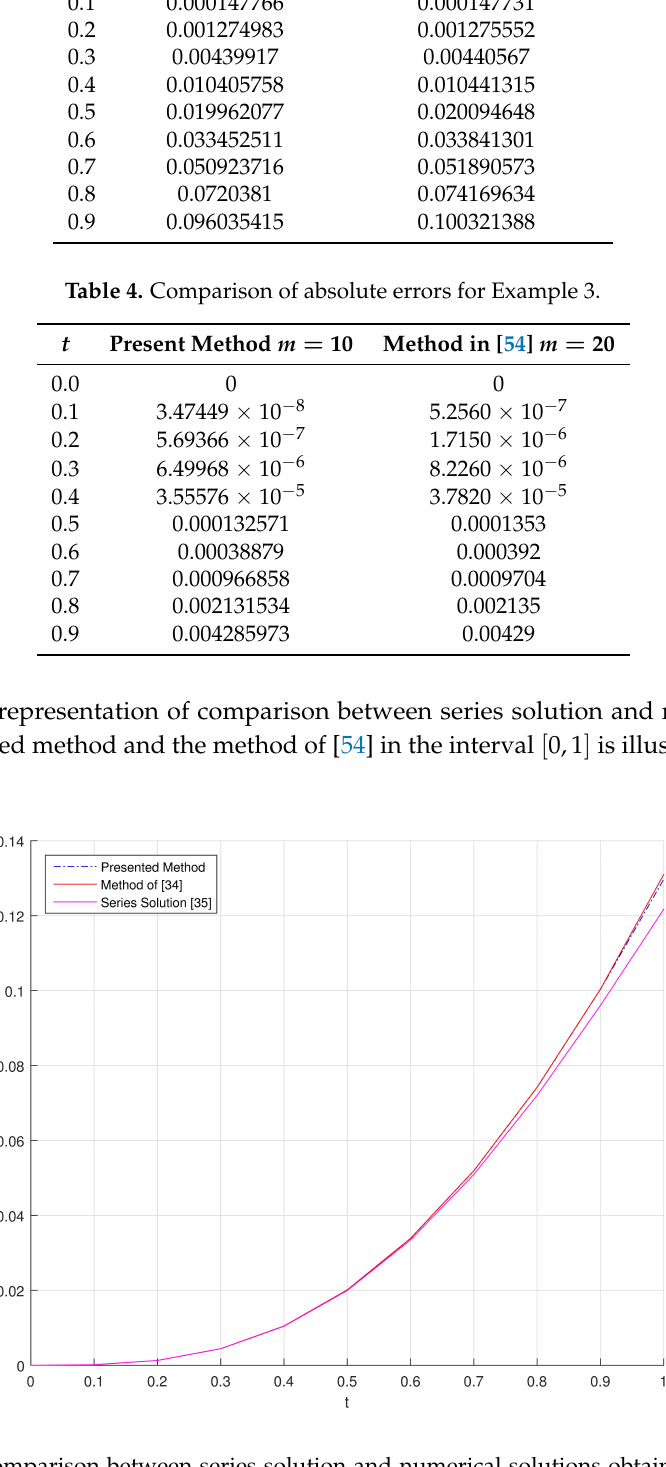
Figure 8. The comparison between series solution and numerical solutions obtained by proposed method and the method of [54] with m =